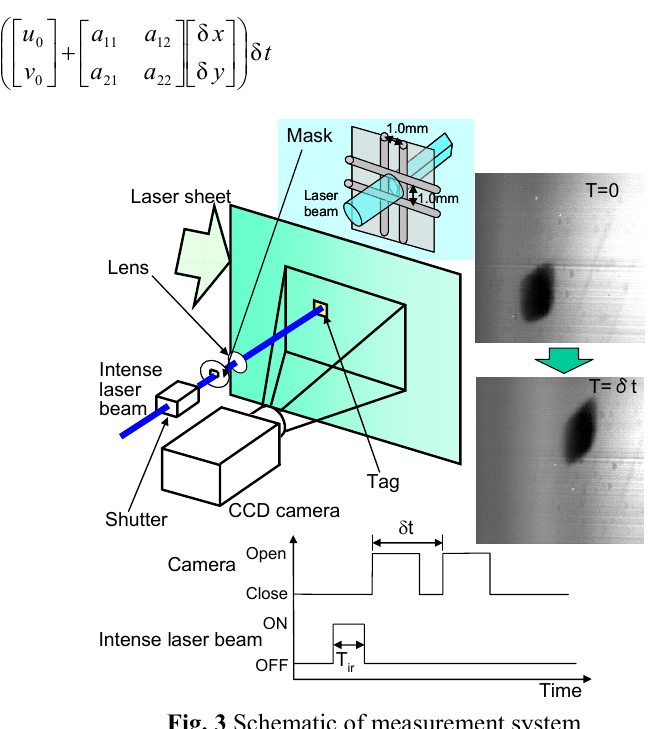
Fig. 3 Schematic of measurement